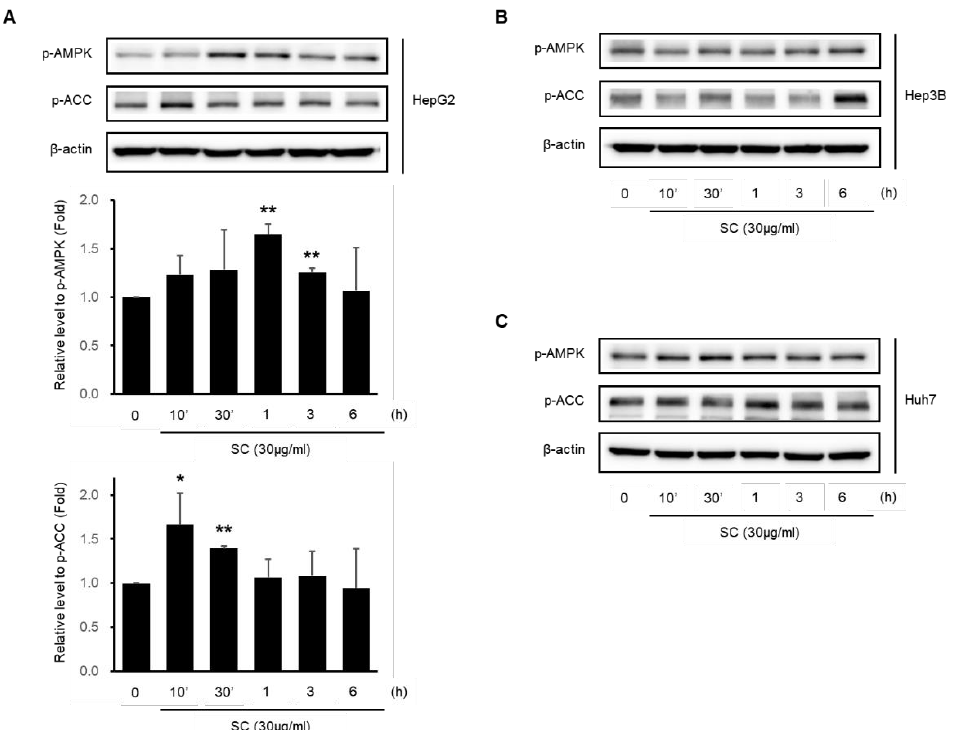
Figure 3. Effect of SC on AMPK activation. Immunoblotting analysis for key signaling proteins of the AMPK signaling pathway was performed with HepG2 ( A ); Hep3B ( B ); and Huh-7 ( C ) cell lysates. The cells were incubated in serum-free media for 12 h, followed by treatment with 30 µ g/mL SC for the indicated time. Expression of p-AMPK and p-ACC in HepG2 represents the mean ± SD (* p < 0.05, ** p < 0.01 between control and SC-treated cells). Int. J. Mol. Sci. 2022 , 23 , x FOR PEER REVIEW